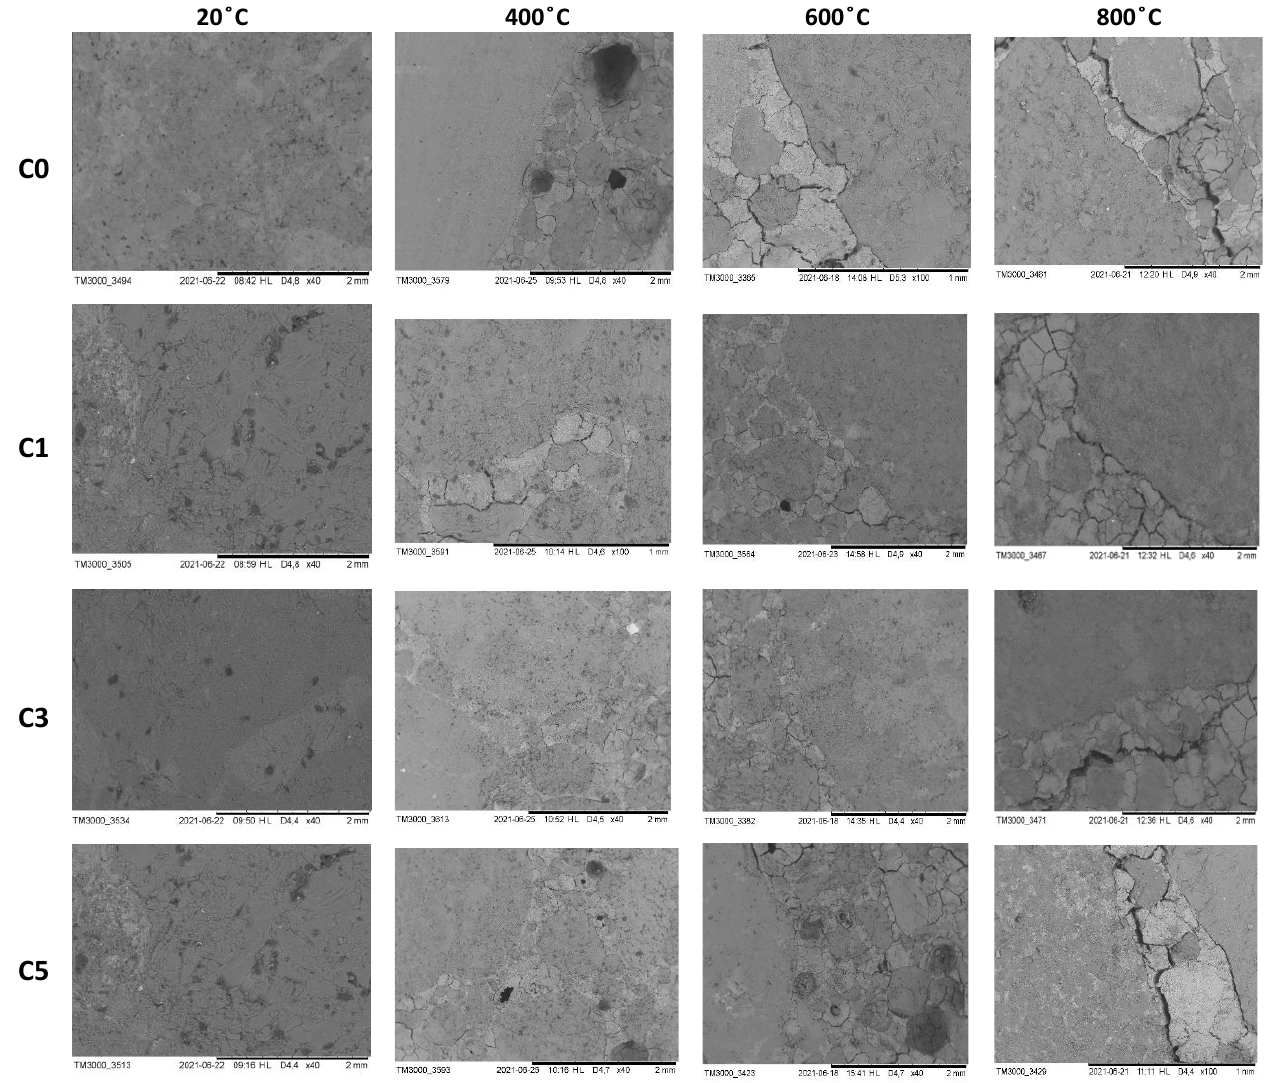
Figure 16. SEM images of the fractures of specimens with various NS contents after heating at a temperature from 400 to 800 °C.